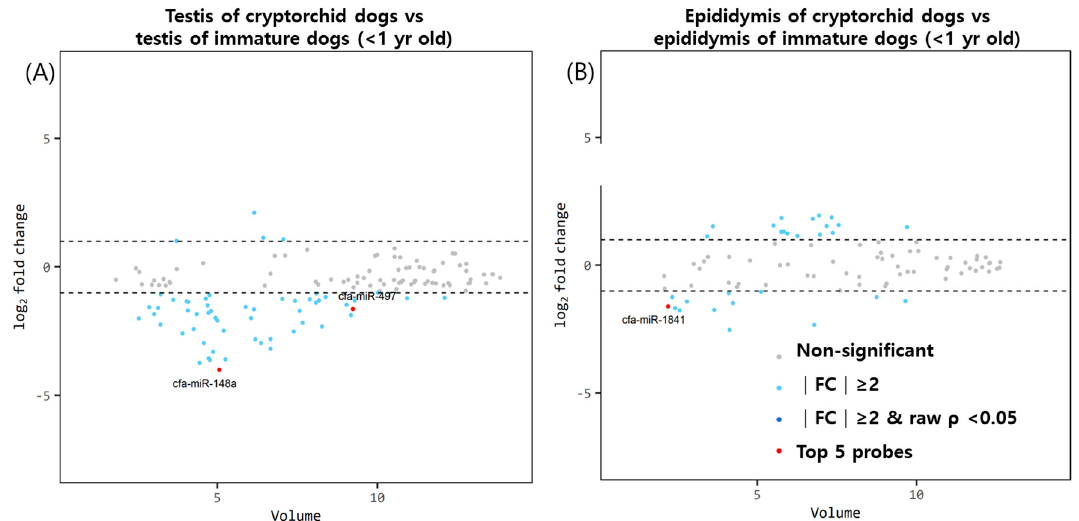
Figure 3. Volume plots of miRNAs in the ( A ) testis and ( B ) epididymis of cryptorchids dogs compared with dogs younger than 1 year of age. The volcano plot illustrates the fold changes and volumes between the groups. The horizontal line indicates a 2 − fold change difference. The red dots indicate the top five significant miRNAs for comparison. The blue and sky − colored dots represent significant differences above a 2-fold change without a p -value of <0.05. Cfa-miR = Canis lupus familiaris microRNA. Gray dots signify no meaningful correlation between volume and fold change.